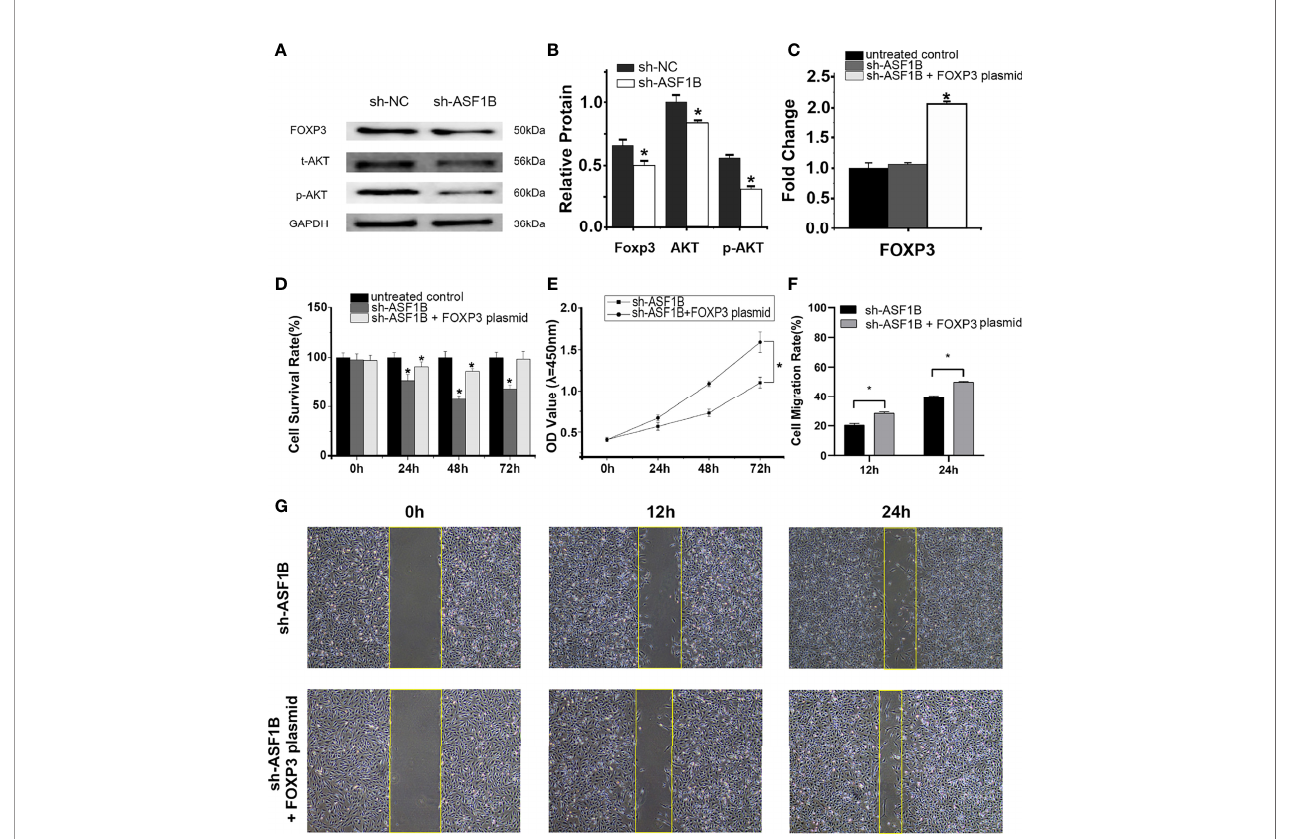
FIGURE 12 | ASF1B targets p-AKT, AKT, and FOXP3, and rescue assays con fi rm that FOXP3 is an important downstream effector of ASF1B. Western blot analyses (A) and relative protein level test (B) indicated that ASF1B silencing decreased p-AKT, AKT, and FOXP3 protein levels, * p < 0.05. (C) RT-qPCR con fi rmed the overexpression of FOXP3 in FOXP3 overexpressing plasmid-transfected group, * p < 0.05. (D) Cell proliferation was detected by CCK-8 assays for three separate treatments, * p < 0.05. (D) The effect of FOXP3 overexpression on in ASF1B-silenced KTC-1 cell proliferation was determined by CCK-8 assay, * p < 0.05. (F, G) Cell migration activity was performed by wound healing assay in ASF1B-silenced KTC-1 cells after transfection with FOXP3-overexpressing plasmid or empty plasmid, * p <